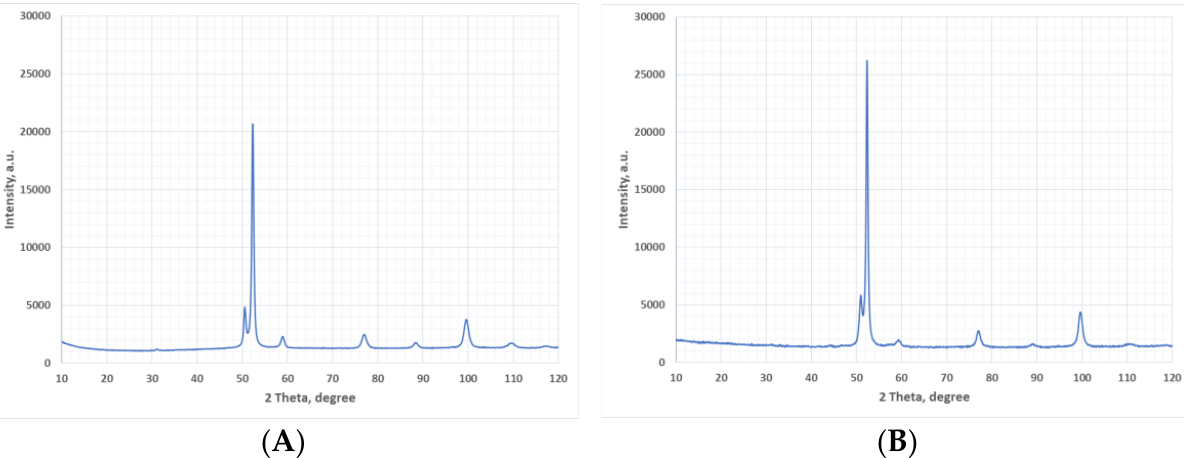
Figure 16. Examples of X-ray diffractograms for ADI_1200 cast iron: ( A ) initial state, ( B ) after wear test.